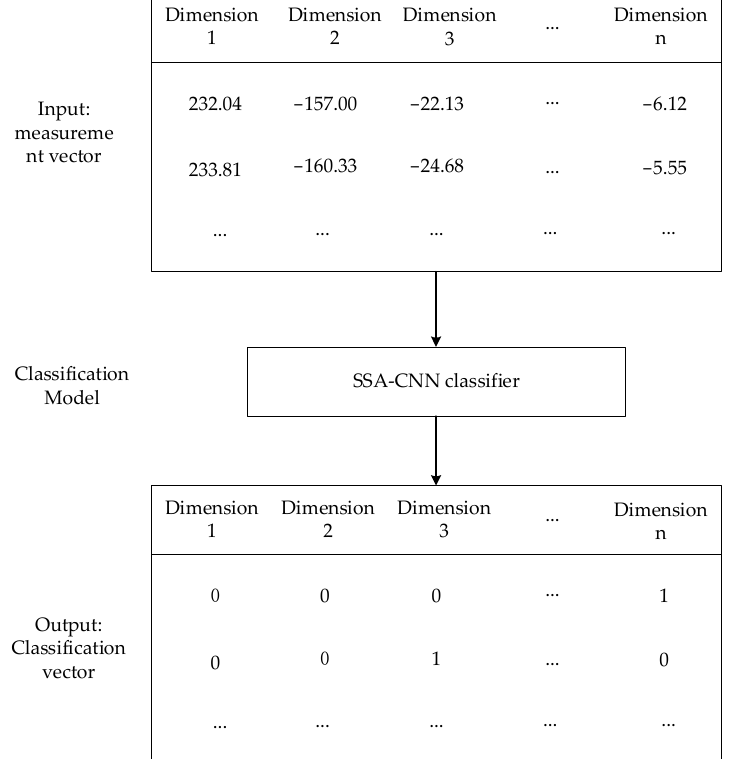
Table 1. Information of the IEEE14-bus Test System.